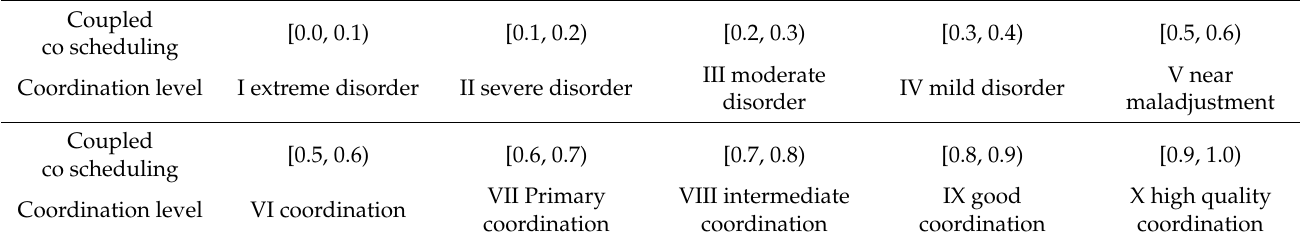
Table 2. The Classification of